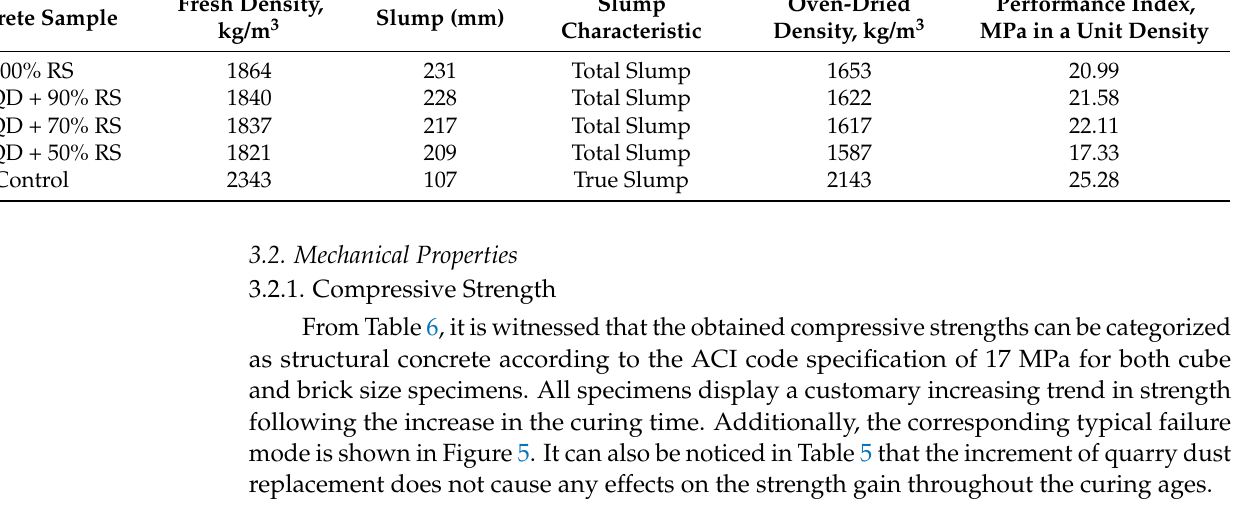
Table 6. Strength at different concrete ages.